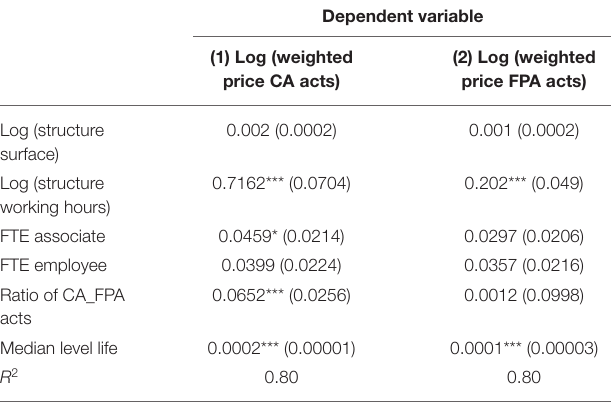
TABLE 7 | Results of the regression models of the association between the variables characteristic of veterinary practices, the median standard living and the weighted price of CA acts (1) and weighted price of FPA acts (2).